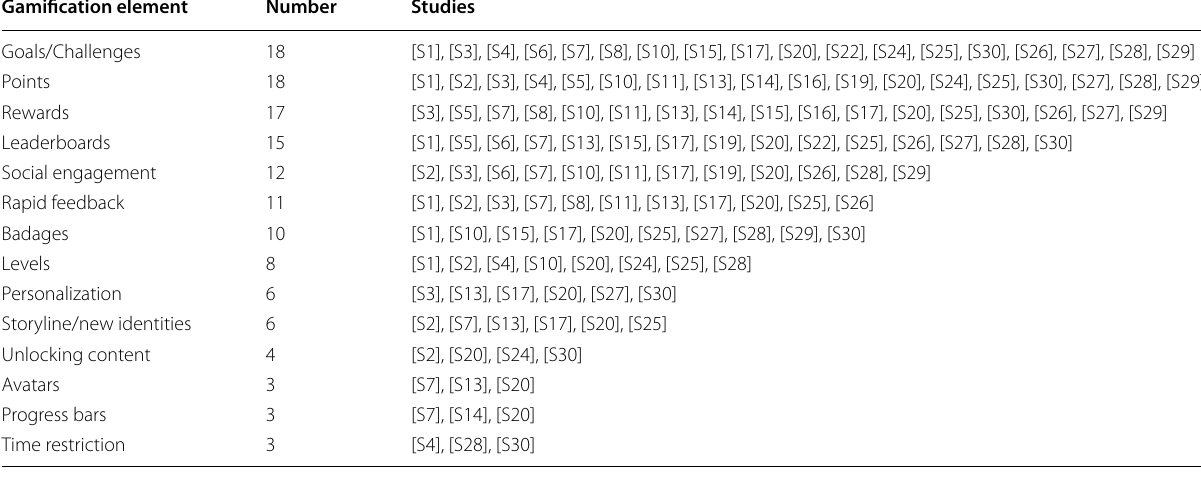
Table 7 Occurrence of gamification elements in selected studies Gamification element Number